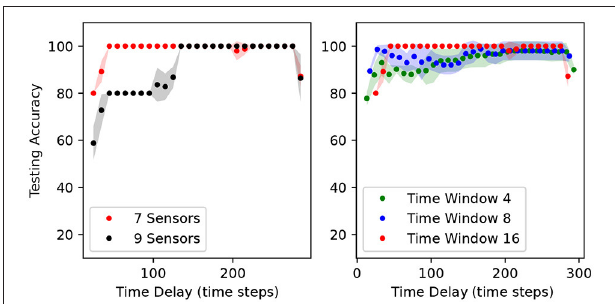
FIGURE 7 | Classification accuracy vs. time delay for the seven and nine sensor combinations (left) and accuracy for the seven sensor combination for different time window lengths (right) . The dots indicate the mean and the shadowed regions indicate the standard deviation over five runs of ANNs independently trained with random initialization